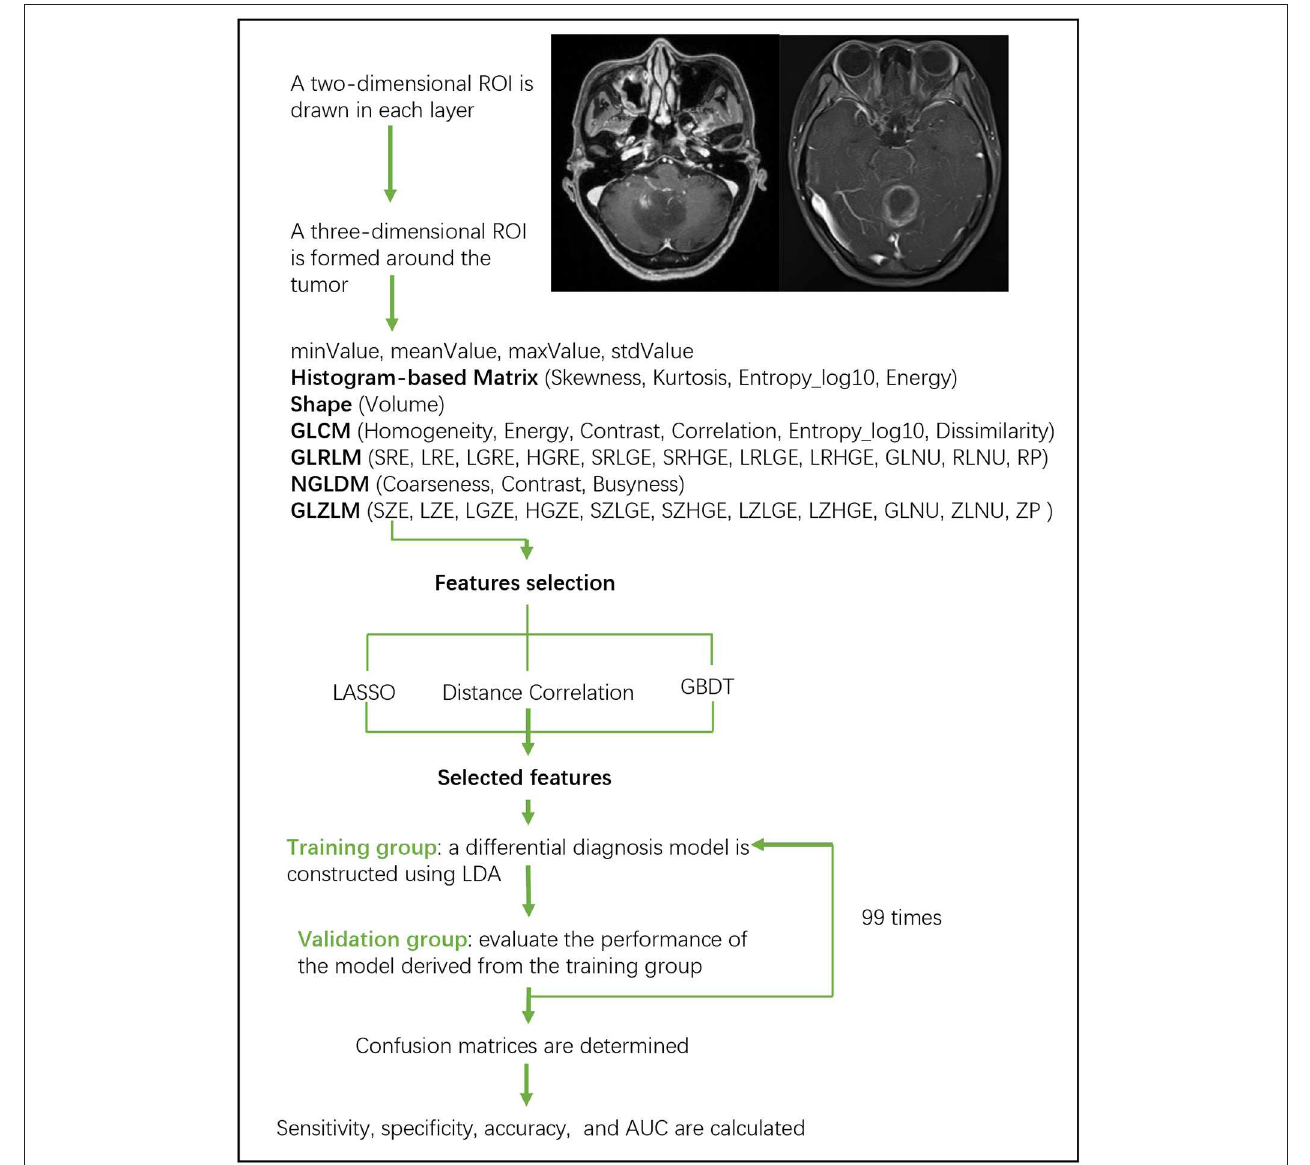
FIGURE 1 | Flowchart of MRI classification by texture features. ANA, anaplastic astrocytoma; LDA, linear discriminant analysis; MRI, Magnetic Resonance Imaging; LASSO, least absolute shrinkage and selection operator; GBDT, gradient correlation decision tree; HISTO, histogram-based matrix; GLCM, Gray-level co-occurrence matrix; GLRLM, Gray-level run length matrix; GLZLM, Gray-level zone length matrix; NGLDM, Neighborhood gray-level dependence matrix; AUC, area under the receiver operating characteristic